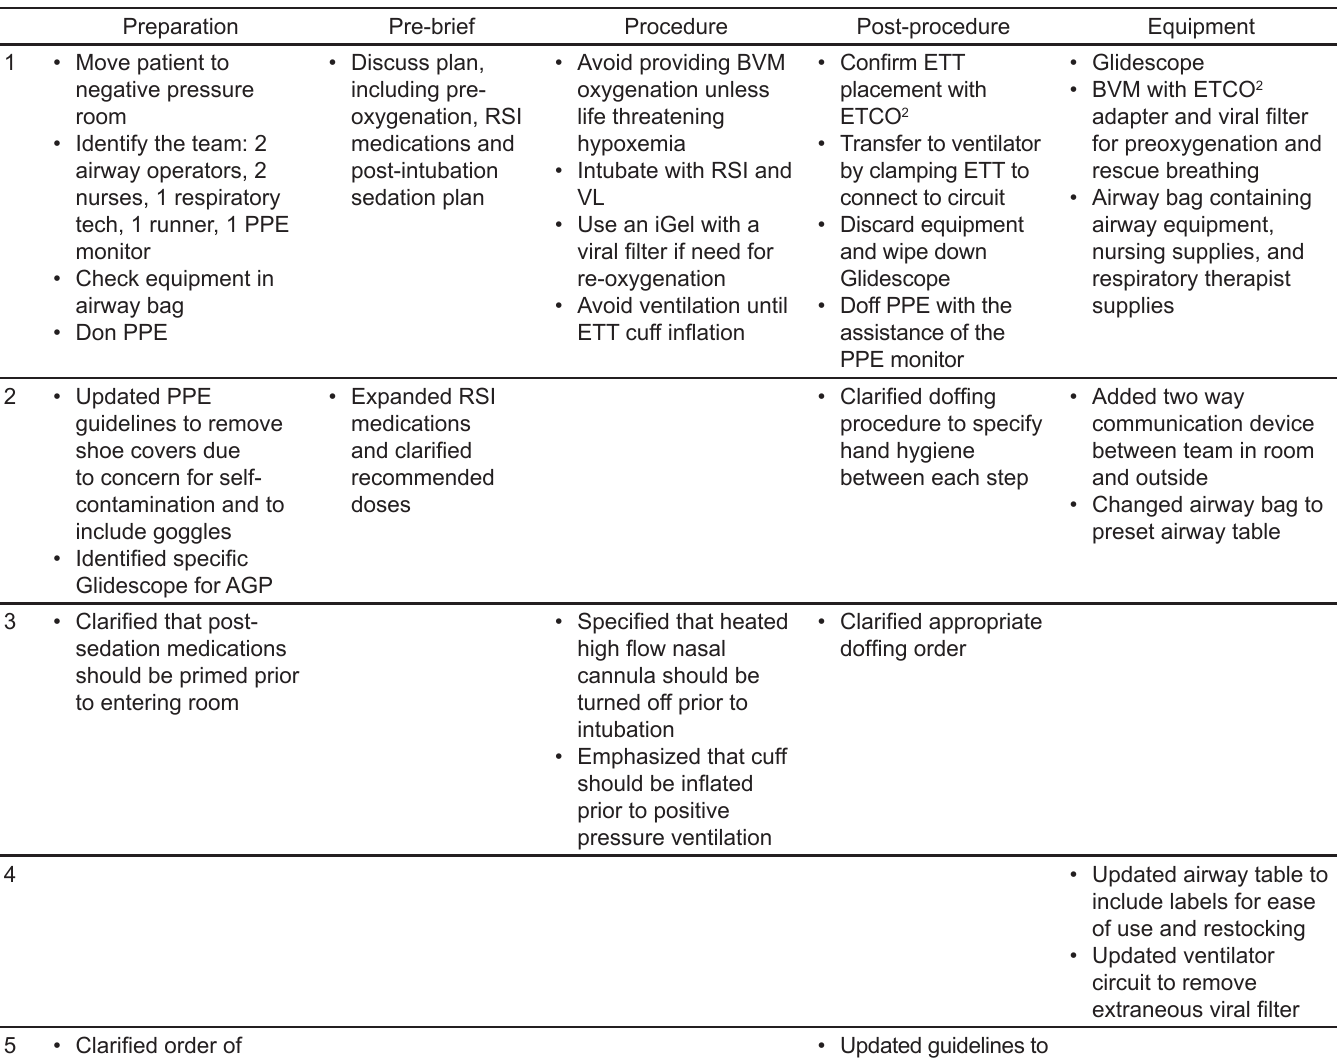
Table 3. COVID-19 airway algorithm change